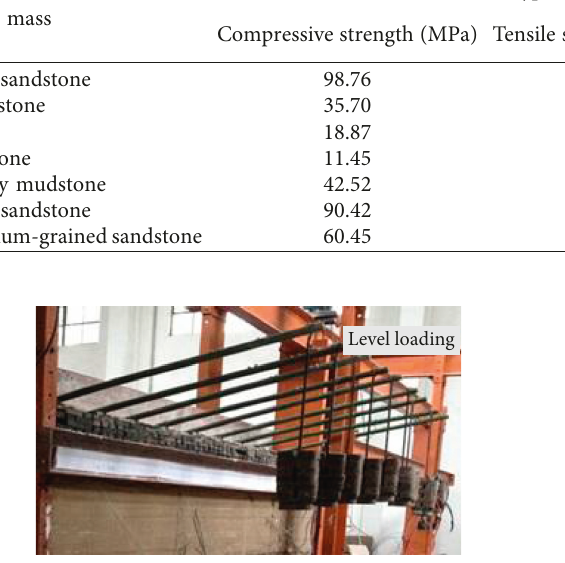
Figure 3: Loading devices used for physical